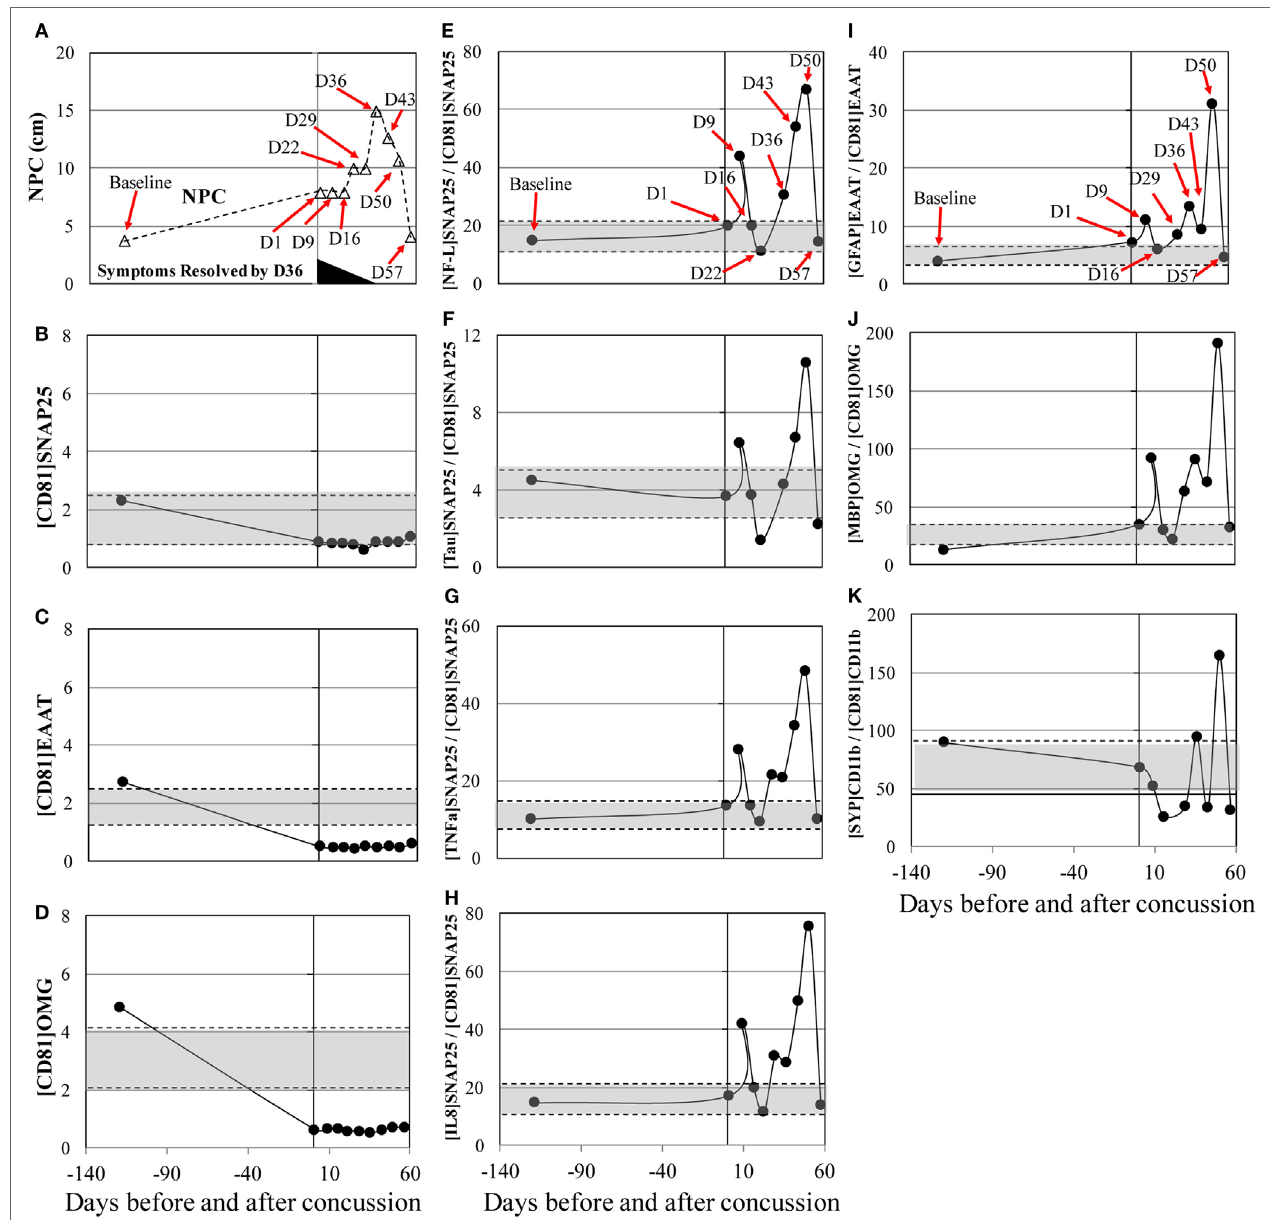
FigUre 2 | Concussion case 2: persisted symptoms. X axis is days before and after concussion, with day 0 being the day of concussion. (a) : clinical assessment of near point of convergence (NPC) ( Δ ). (B) : [CD81] SNAP25 + (U/mL), (c) : [CD81] EAAT1 + (U/mL), (D) : [CD81] OMG + (U/mL), (e) : [NF-L] SNAP25 + /[CD81] SNAP25 + ratio, (F) : [Tau] SNAP25 + /[CD81] SNAP25 + ratio, (g) : [TNF α ] SNAP25 + /[CD81] SNAP25 + ratio, (h) : [IL8] SNAP25 + /[CD81] SNAP25 + ratio, (i) : [GFAP] EAAT1 + /[CD81] EAAT1 + ratio, (J) : [MBP] OMG + /[CD81] OMG + ratio, and (K) : [SYP] CD11b + /[CD81] CD11b + . + 50% from pre- and post-season average values was shown in shaded blanket as referential values. SNAP25, synaptosome- associated protein 25, NF-L, neurofilament light polypeptide; TNF α , tumor necrosis factor-alpha; IL8, interleukin-8; EAAT1, excitatory amino acid transporter 1; GFAP, glial fibrillary acidic protein; OMG, oligodendrocyte myelin glycoprotein; MBP, myelin basic protein; SYP,